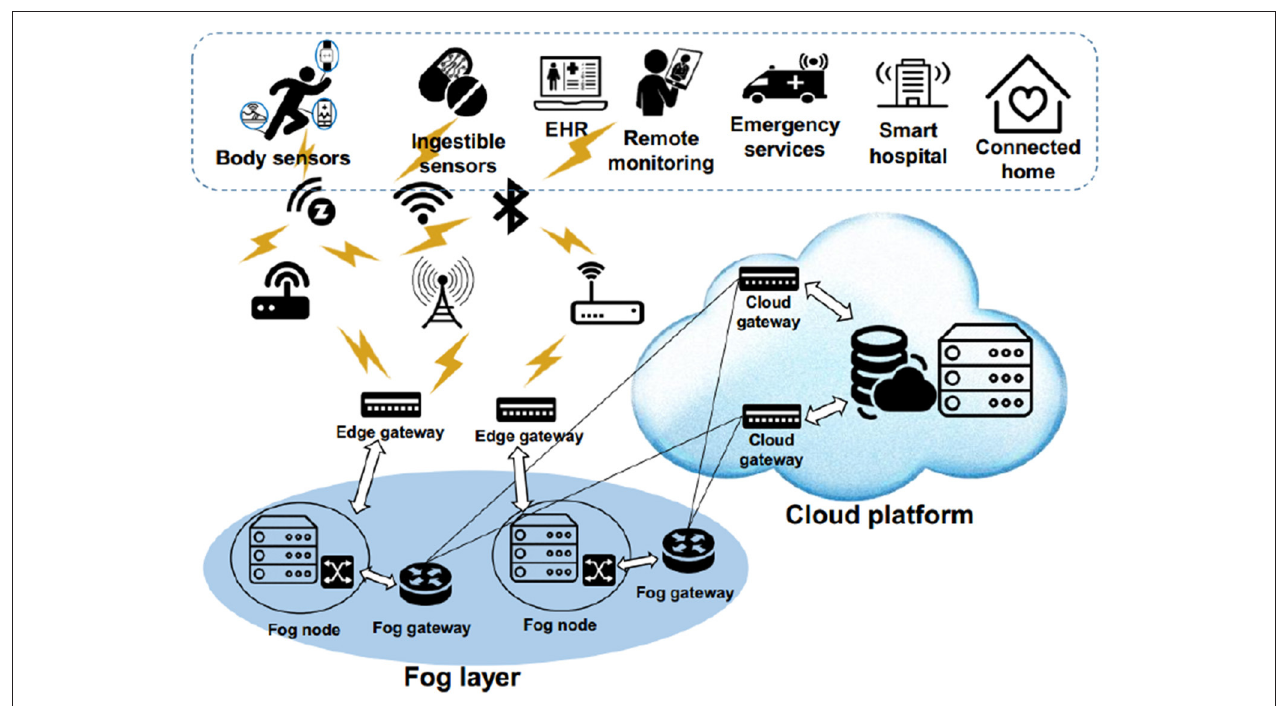
FIGURE 2 | Various HIoT applications